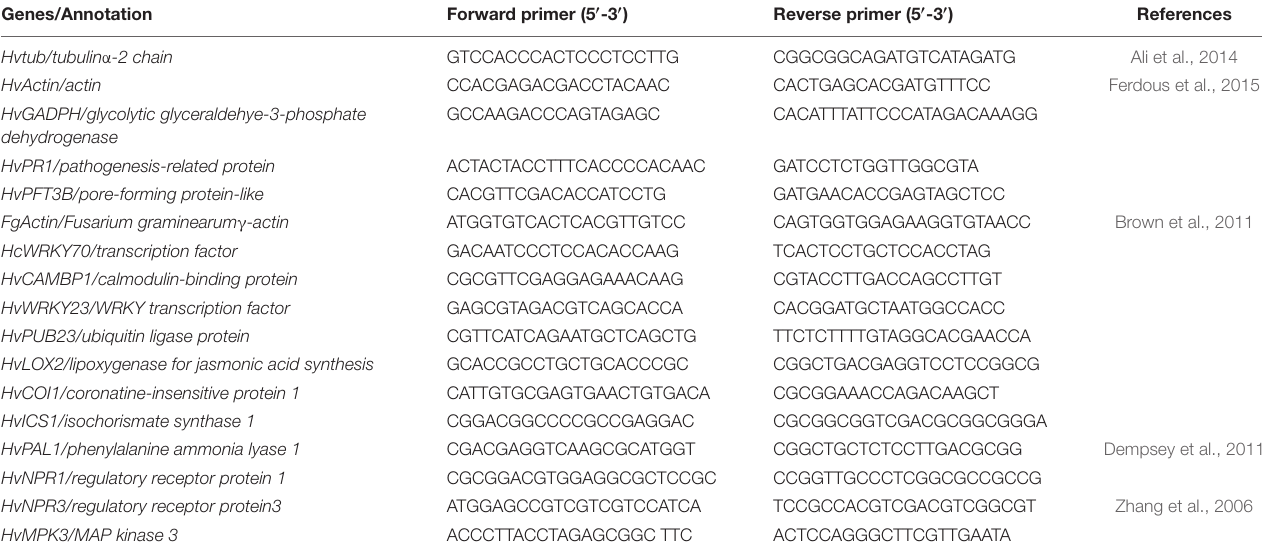
TABLE 2 | List of genes and primers used for real-time expression studies. Genes/Annotation Forward primer (5 (cid:48) -3 (cid:48) ) Reverse primer (5 (cid:48) -3 (cid:48) )